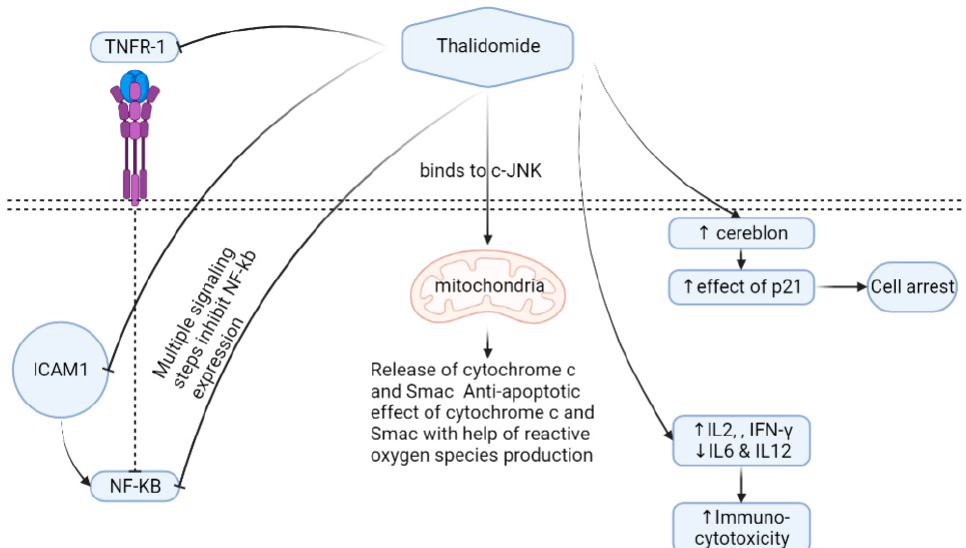
Figure 1. Thalidomide mechanism of action. Cells expressing the cereblon protein show higher expressions of p21 if thalidomide is administrated, leading to cell arrest. Thalidomide can also increase immuno-cytotoxicity through the regulation of different cytokines. Thalidomide has a direct effect on mitochondria through binding to c-JNK, followed by releasing oxygen species. The inhibition of NF-KB occurs as a means for thalidomide by interacting with TNFR-1, ICOM1, and other multistep signaling. Abbreviations, c-JNK—c-jun terminal kinase; TNFR1—tumor necrosis